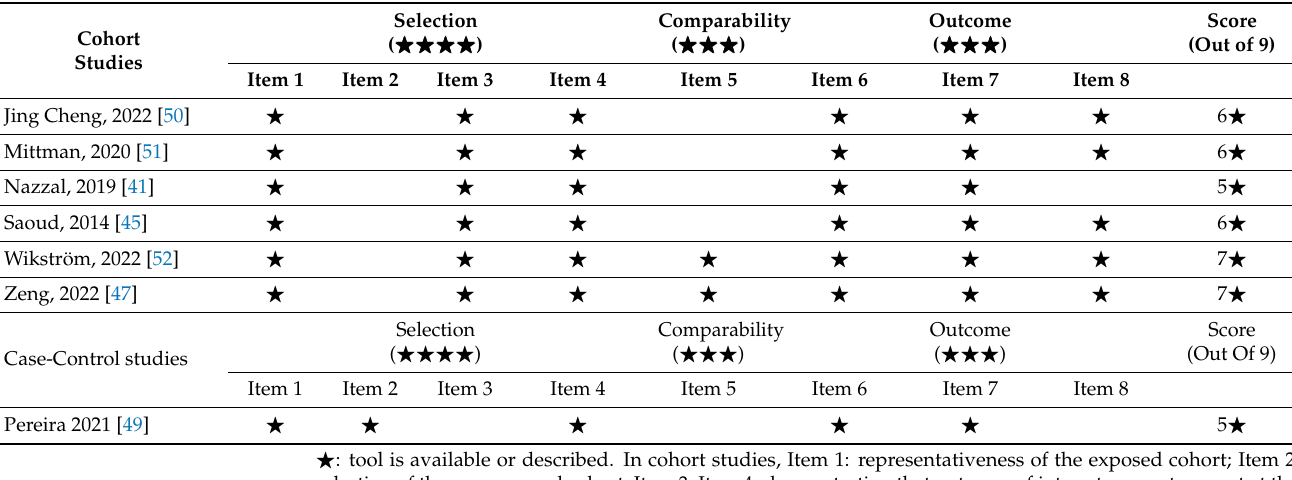
Table 3. Newcastle–Ottawa scale for cohort and case-control studies.